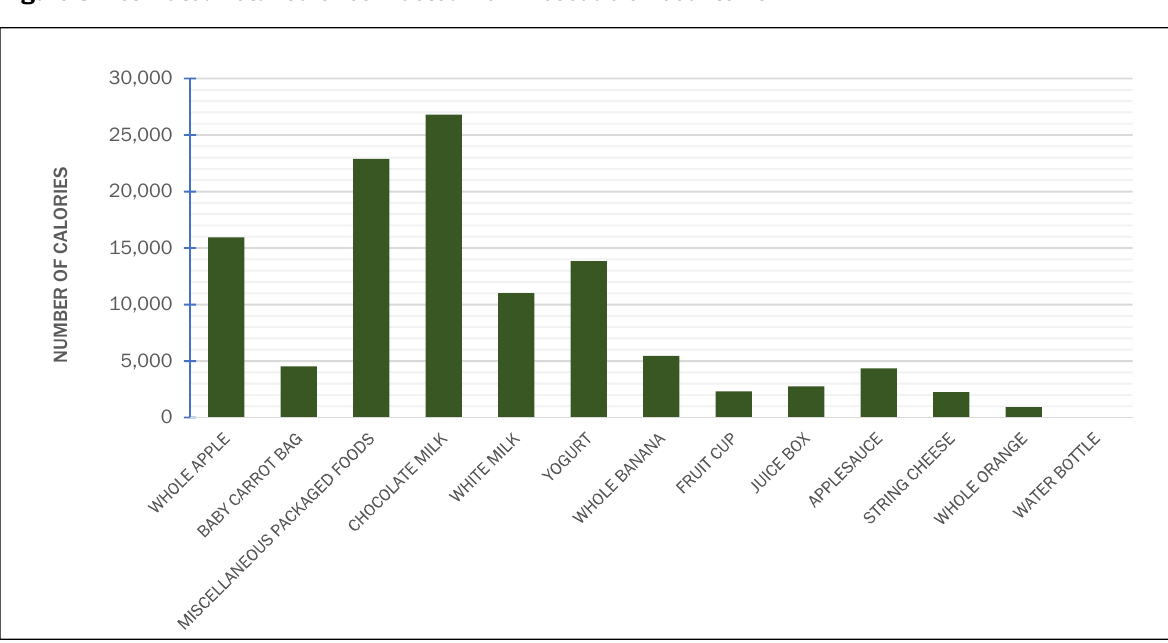
Calories amounts were determined according to the USDA National Nutrient Table 4. Nutrient Loss of Nutrients of Concern for Students from Rescuable Vegetables, Fruit, and Dairy Calculations performed using the Nutrient Loss and Recovery Calculator (Spiker, 2017). Dietary reference intakes are